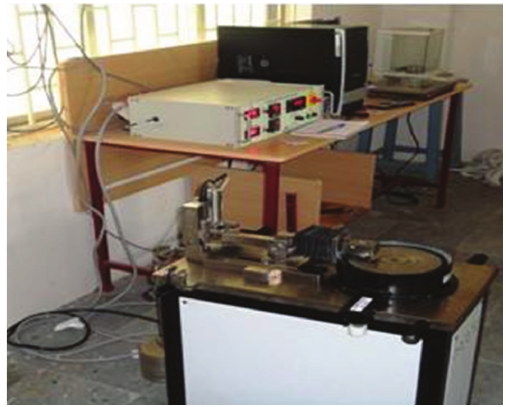
F 3: Pin-on-disc